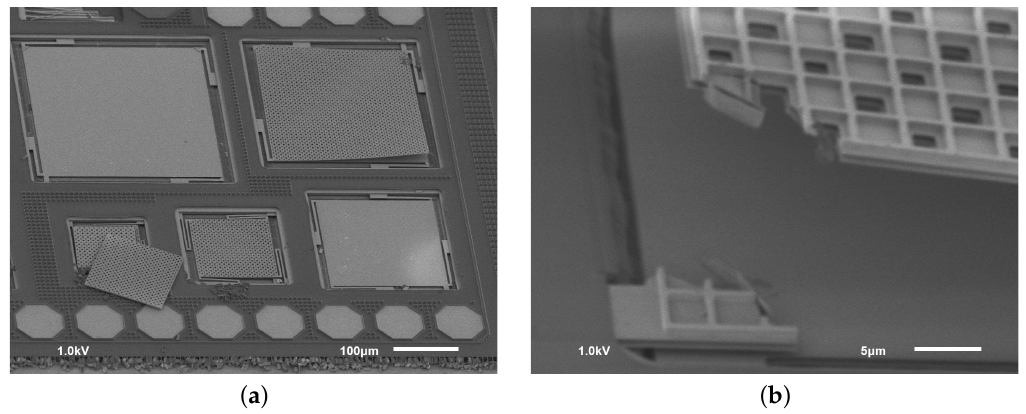
Figure 5. Typical failures on Accused chip: delamination of TM1 layer, contamination with metal fillers from the cut area and corner cracks ( a ). Zoomed corner ( b ) reveals that multi-layer plate is released before the suspension and the corner, weakened by the perforations, cracks due to